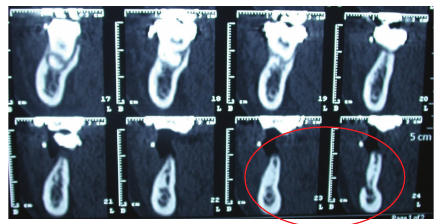
Figure 9: CT DentaScan.